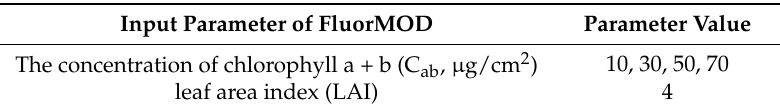
Table 1. Parameters of the vegetation spectrum with different chlorophyll contents simulated by FluorMOD.